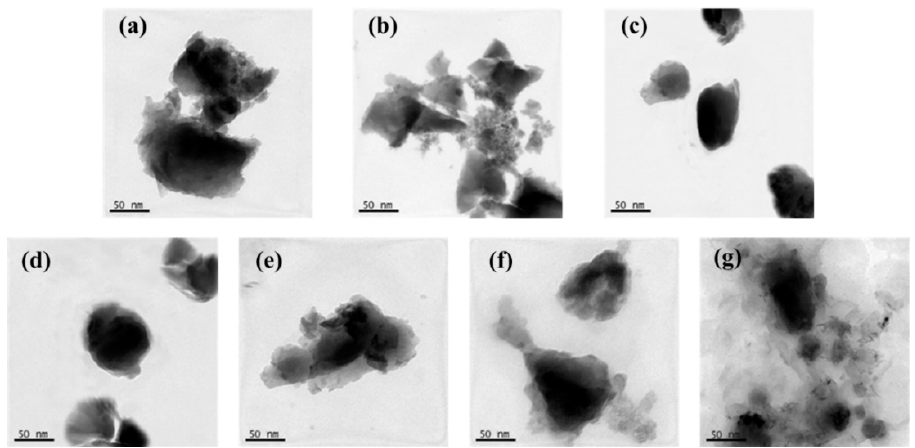
Figure 2 . TEM micrographs of ( a ) ANC, ( b ) ATANC, ( c ) FANC 5 , ( d ) FANC 10 , ( e ) FANC 12.5 , ( f ) FANC 15 , and ( g ) FANC 20 specimens.